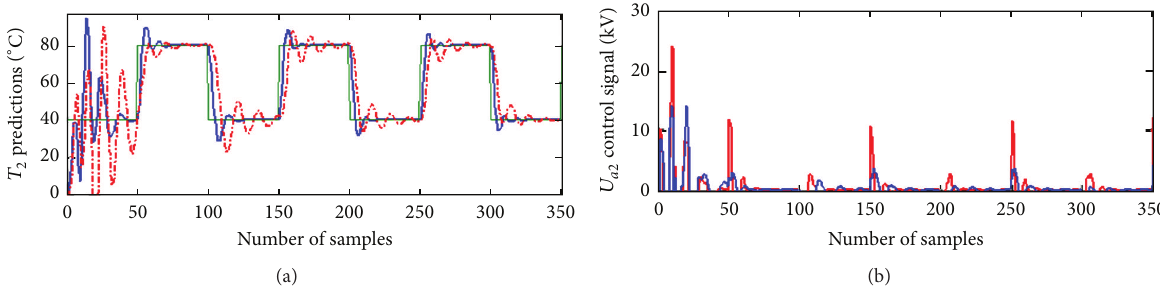
Figure 9: Pickling temperature predictions by GPC (red dots) and DNN-ADNMPC (blue solid) for (a) 𝑇 2 with (b) control signal 𝑈 𝑎2 to trace the desired reference signal (green solid).